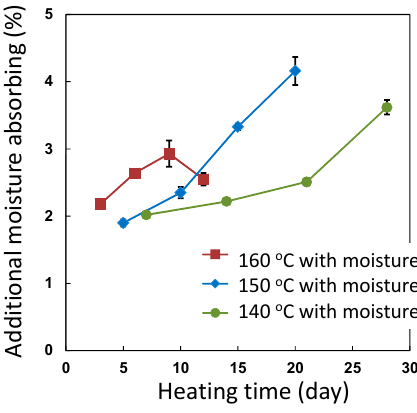
Figure 10. Bending strength of degraded CFRP samples during heating with moisture at 140, 150 and 160 °C and bending strength at 160 °C without moisture for 12 days.